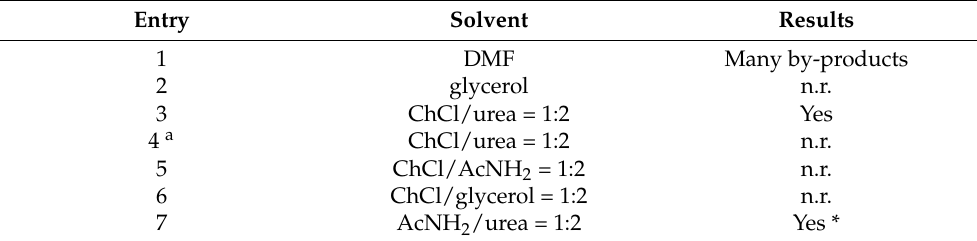
Table 3. Screening of the solvents in the aminolysis of FDCA-bis-CC by the Jeffamine D-2000. Entry Solvent Results DMF Many